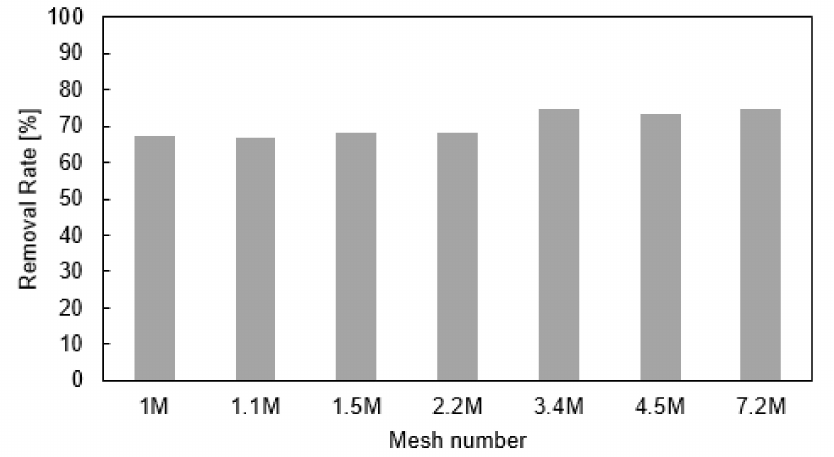
Figure 2. Comparison of inclusion removal rate obtained by di ff erent mesh number (inclusion density: 3500 kg m − 3 ; inclusion size: 40 µ m; Case 1-W +